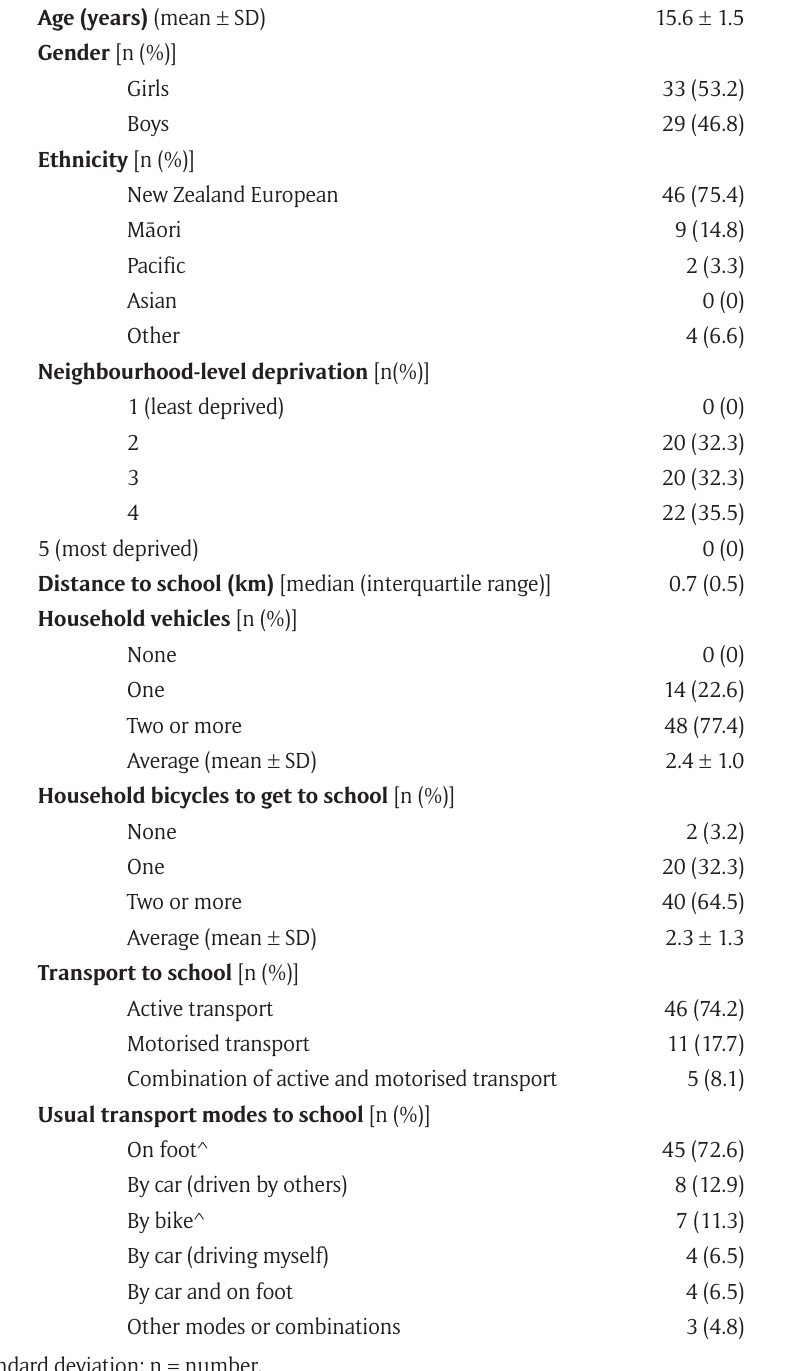
Table 1: Adolescents’ sociodemographic and school travel